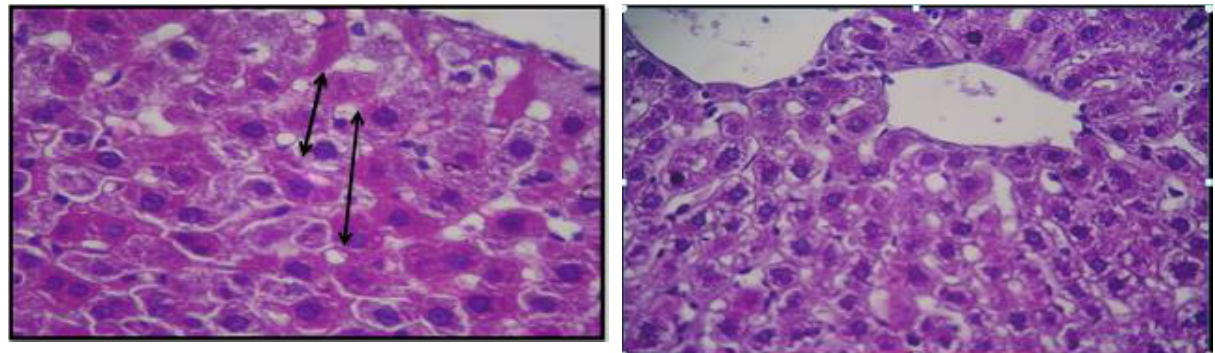
Figure-5: Photomicrographs showing histology of liver tissue from group T1 showed presence of PMNCs in the dilated and congested blood vessels mainly in portal area ( H /E X 40).